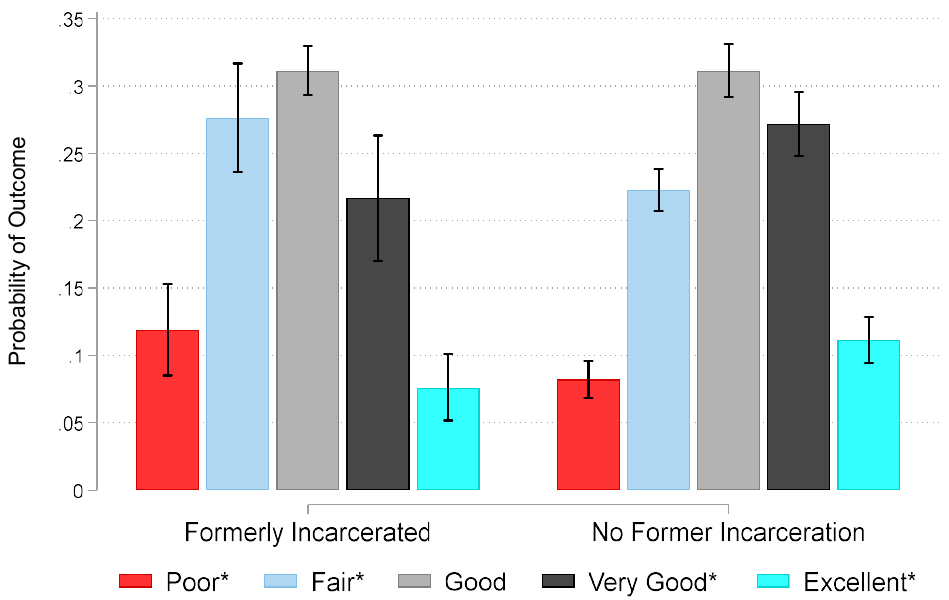
Figure 1. Predictions of Oral Health among African American Women in the National Survey of American Life, 2003. Note : Fully-adjusted estimates generated from Model 1 in Table 2 (n = 2144). Probabilities of poor and fair health are significantly higher for formerly incarcerated women. Probabilities of very good and excellent health are significantly lower for formerly incarcerated women. * Probabilities of an outcome are significantly different for formerly and never incarcerated women